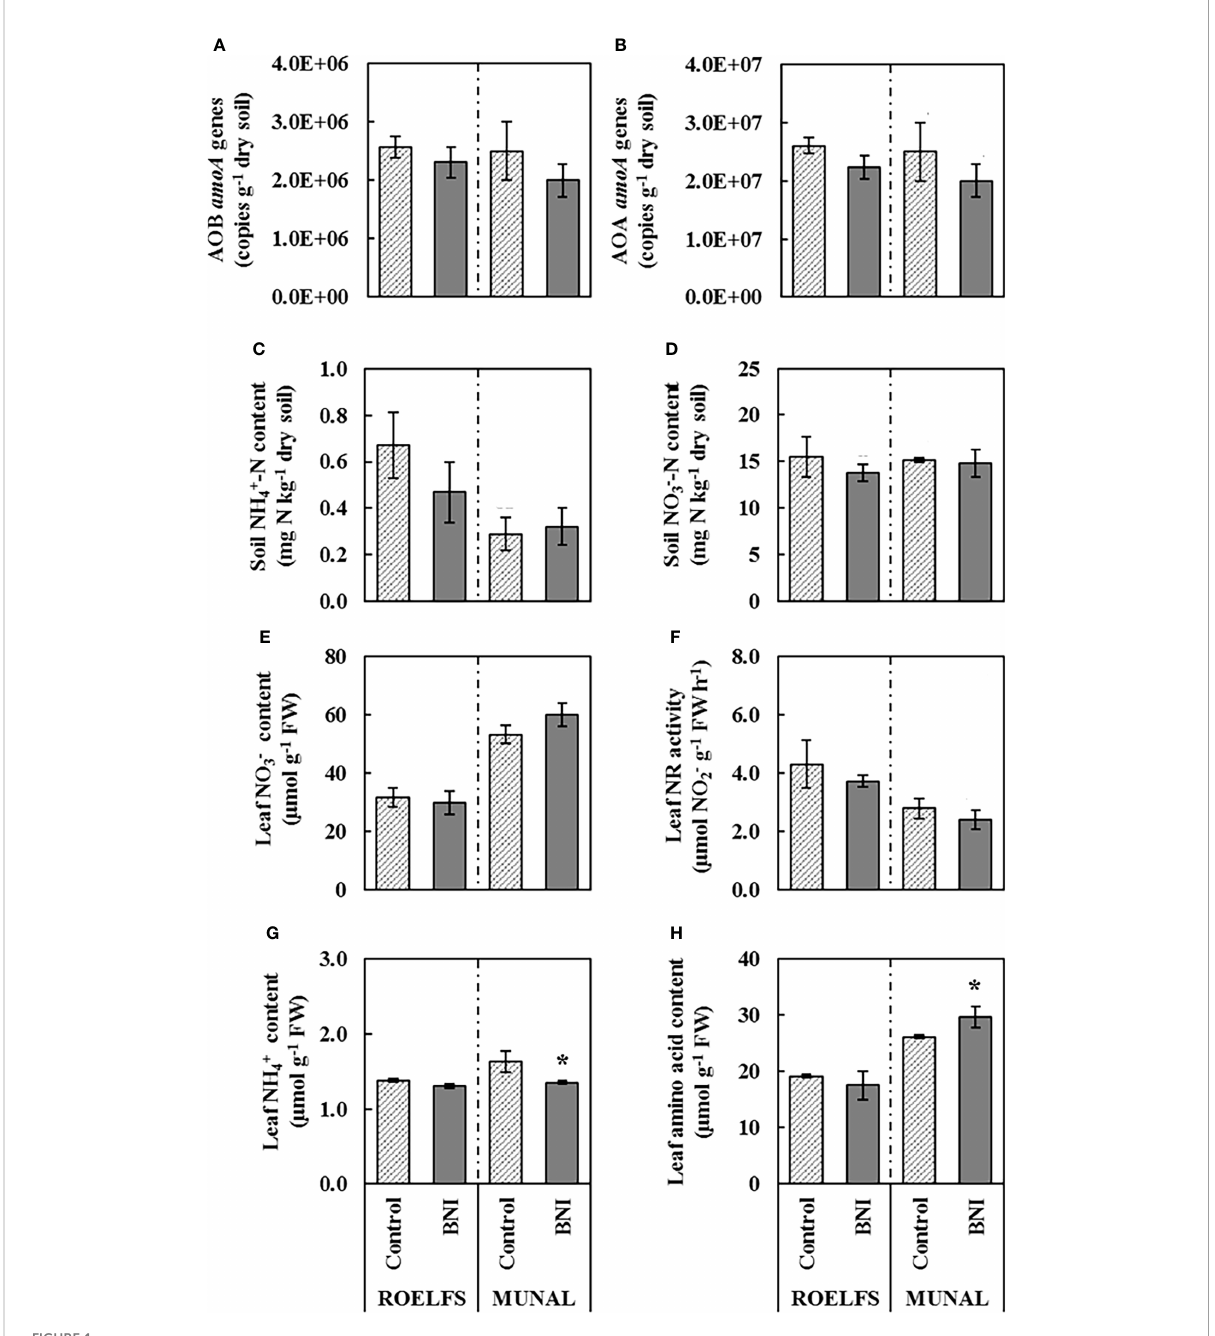
FIGURE 1 Performance of Control and BNI isogenic lines from ROELFS and MUNAL prior to fertilization (TO). Abundance of AOB (A) and AOA (B) , soil mineral nitrogen content such as ammonium (C) and nitrate (D) . and leaf determination of nitrate content (E) , nitrate reductase activity (F) , ammonium content (G) , and amino acid content (H) . The Mann-Whitney U test was used for the comparison between the absence or the presence of BNI-trait and the signi fi cant differences at p <0.05 are marked with an asterisk